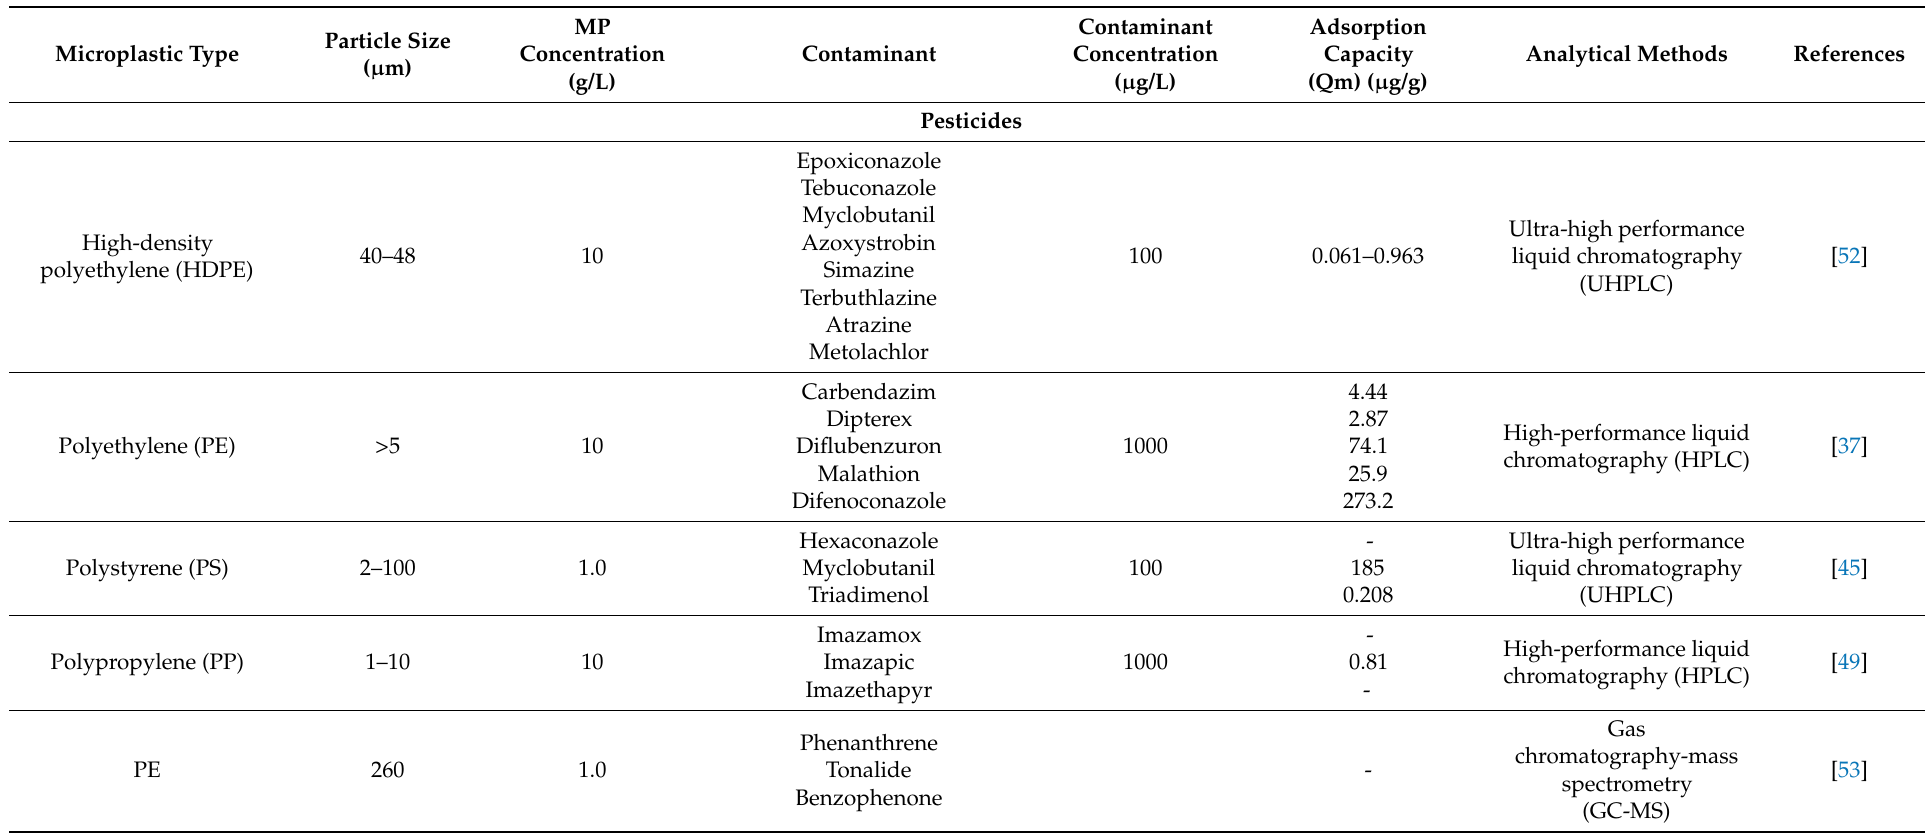
Table 1. Summary of sorption studies (kinetics and equilibrium) for different systems of microplastics/contaminants (pesticides, pharmaceutical and health care products, and